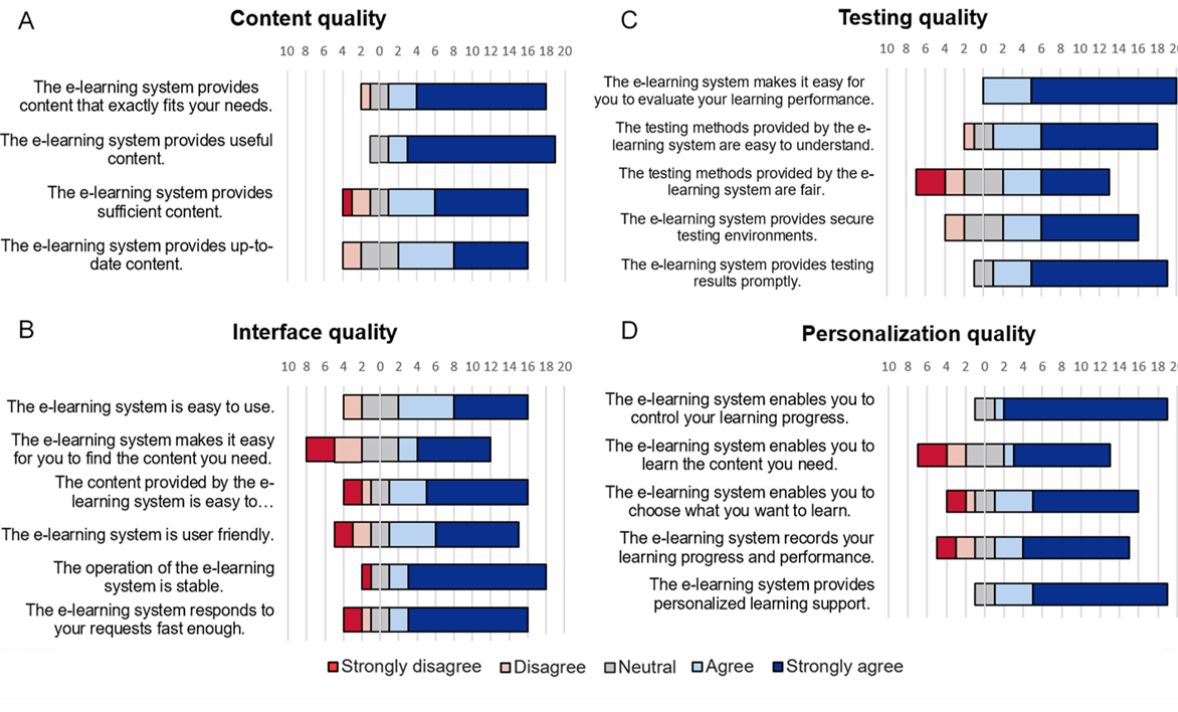
Figure 3. Satisfaction analysis of the system by Gastroscope Roaming System participants in four modules: (A) content quality, (B) interface quality, (C) testing quality, and (D) personalization quality. Each module lists the problems it contains. e-learning: electronic